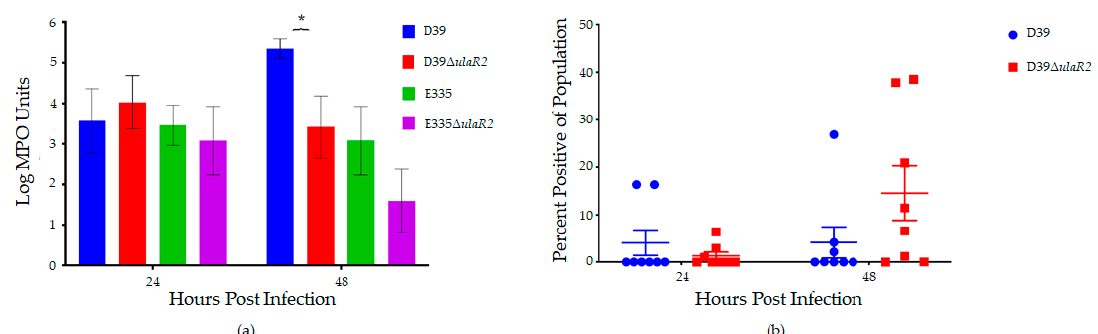
Figure 4. Polymorphonuclear neutrophil (PMN) activity and presence in infected vitreous humor of rabbits. ( a ) Mean Log 10 MPO units of activity calculated from spectrophotometric